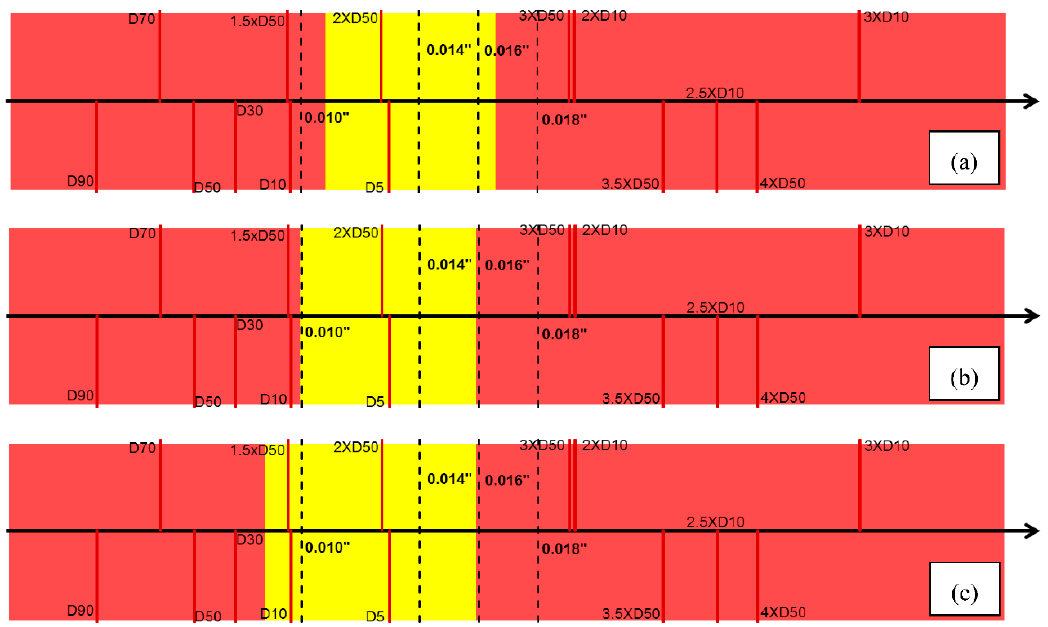
Figure 14. TLS of DC-II in the aggressive condition for SPF 120 ( a ), SPF 168 ( b ), and SPF 216 ( c ).